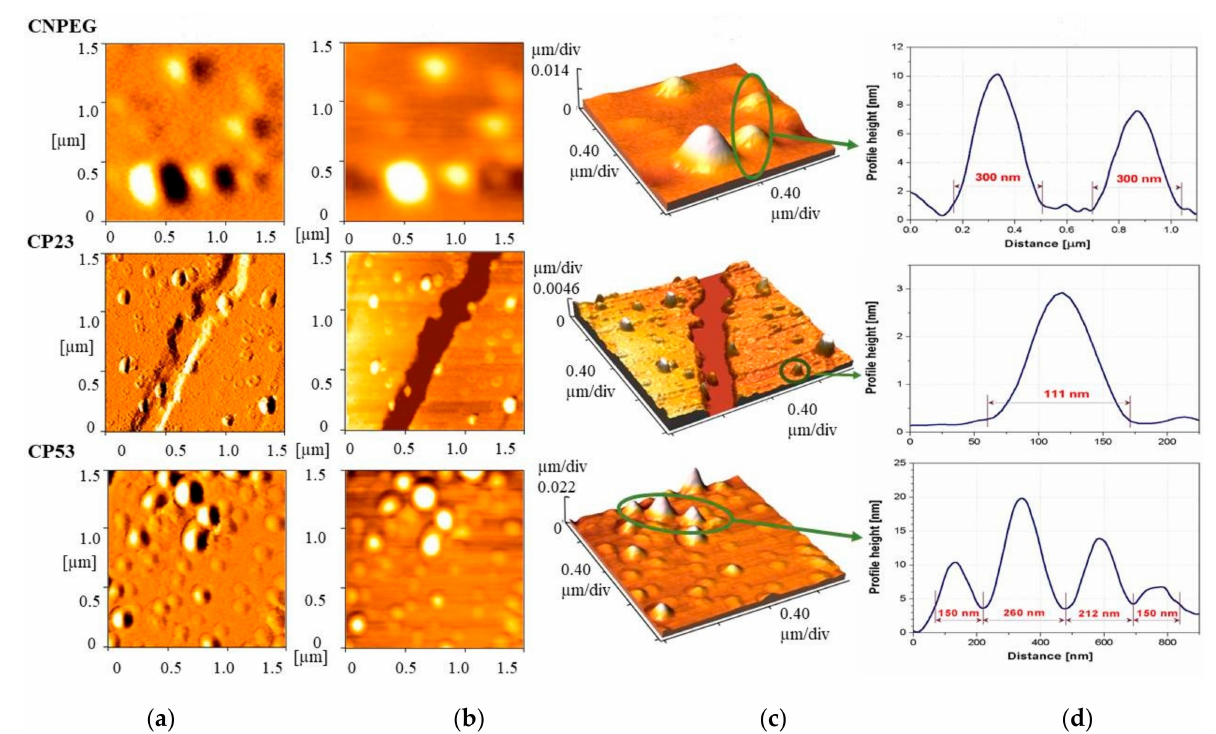
Figure 4. AFM images of curcumin loaded nanoemulsions—non PEGylated (CNPEG) and two PEGylated containing 0.3% of PEG2000-DSPE (CP23) or PEG5000DPPE (CP53): ( a ) error signal of 1.5 × 1.5 µ m 2 area of the sample; ( b ) 2D topography; ( c ) 3D topography; ( d ) height profiles of selected nanoemulsion